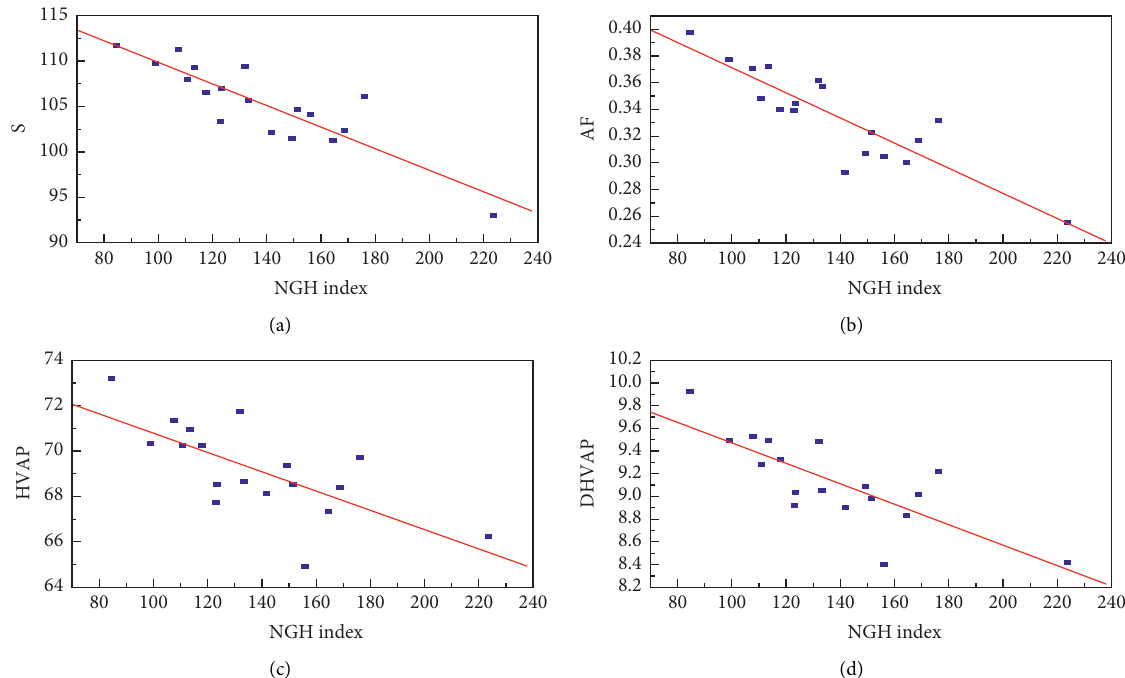
Figure 4: Scatter diagram of physical properties S , AF, HVAP, and DHVAP with the NGH